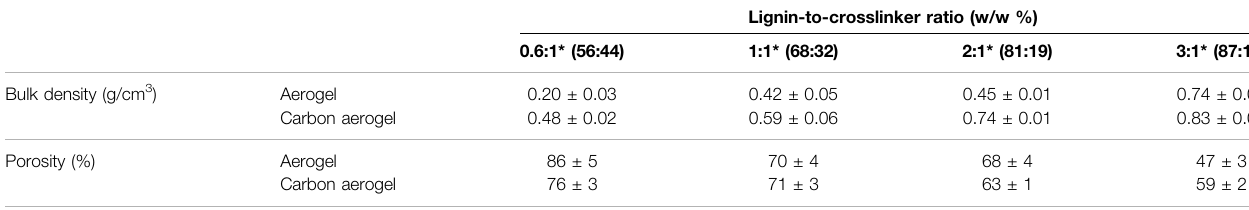
TABLE 1 | Bulk density and porosity of lignin-based aerogels and carbon aerogels prepared with different lignin-to-crosslinker